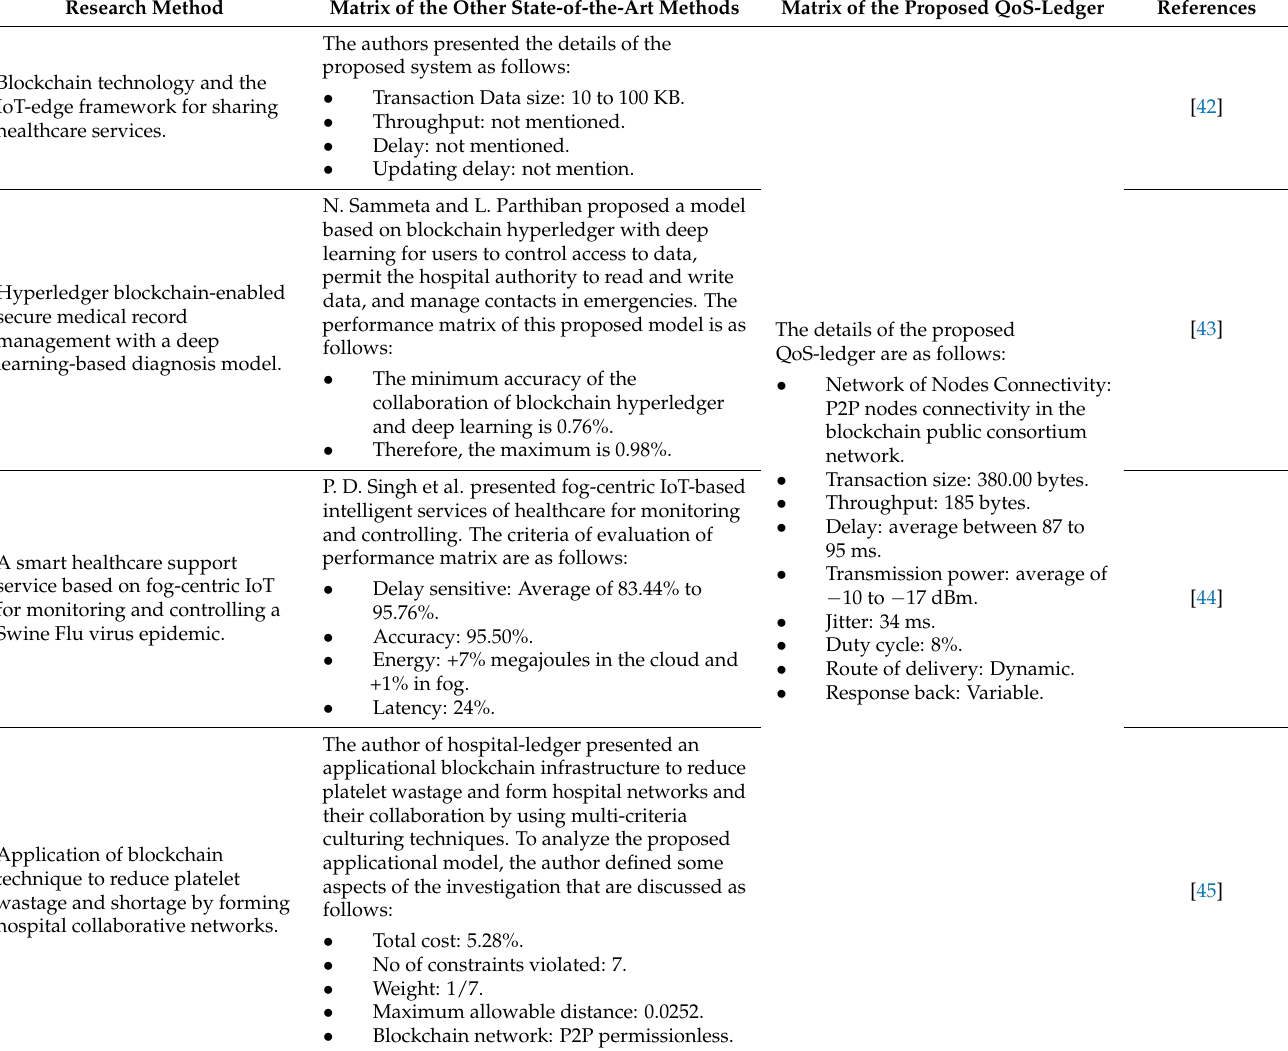
Table 4. A Comparison Table of Other State-of-the-Art